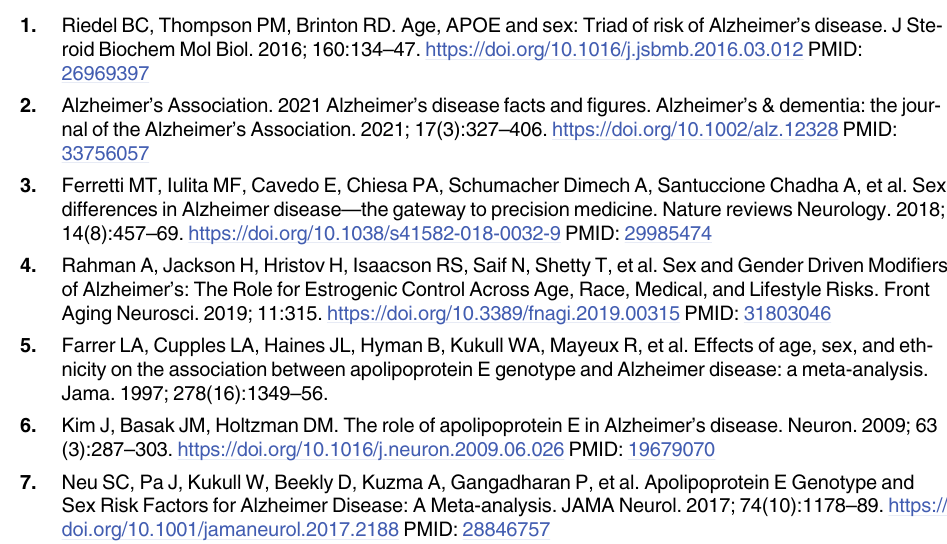
and phospholipids are located to i